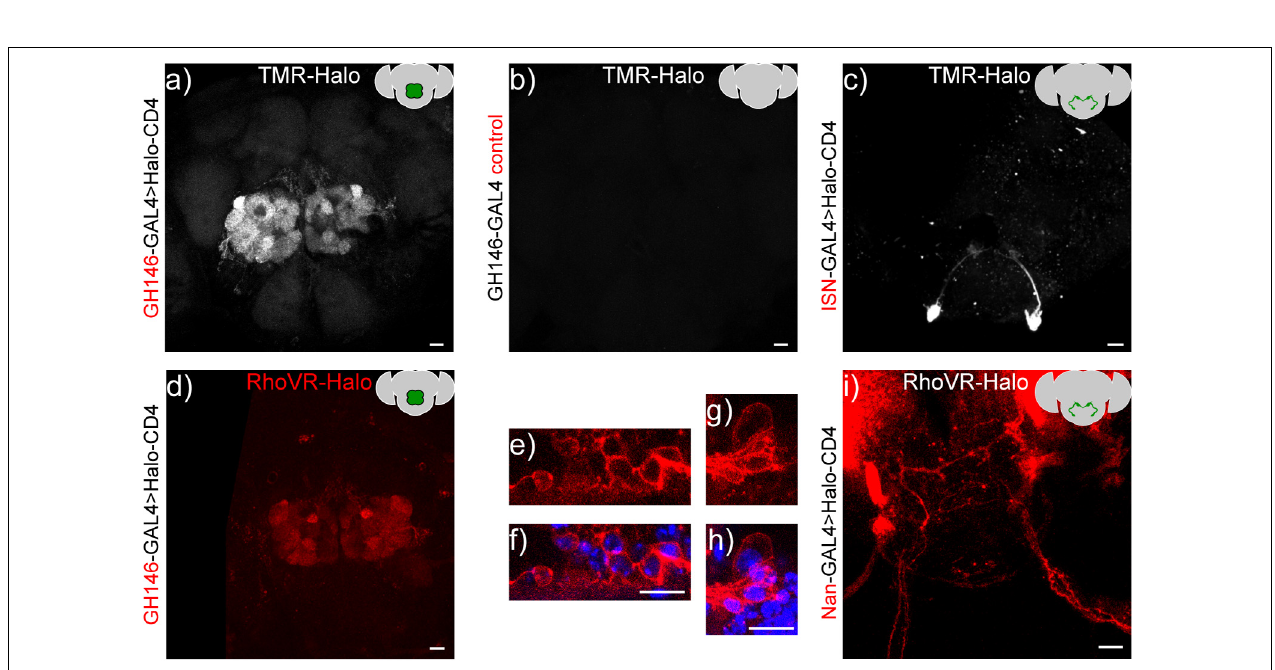
FIGURE 6 | In vivo labeling of Drosophila neurons with TMR-Halo or RhoVR-Halo. Top row: Maximum z-projection of a confocal fluorescence microscopy stack of live brain explants labeled with voltage- insensitive TMR-Halo (1 µ M) in an intact, live-fly before dissection and imaging. Crosses were either (a) GH146-GAL4 > HaloTag-CD4, (b) GH146-only control, or (c) VT011155-GAL4 > HaloTag-CD4. Bottom row. Maximum or sum z-projections of confocal fluorescence microscopy stack of live brain explants labeled with voltage- sensitive RhoVR-Halo (1–2 µ M), labeling either (d–h) projection neurons (GH146-GAL4 > Halo-CD4, max projection) or (I) ISNs (Nan-GAL4 > Halo-CD4, sum projection). (e,g) High magnification images of RhoVR-Halo staining in PNs (red), overlaid with (f,h) Hoechst 33342 nuclear stain (blue). All scale bars are 20 µ m.